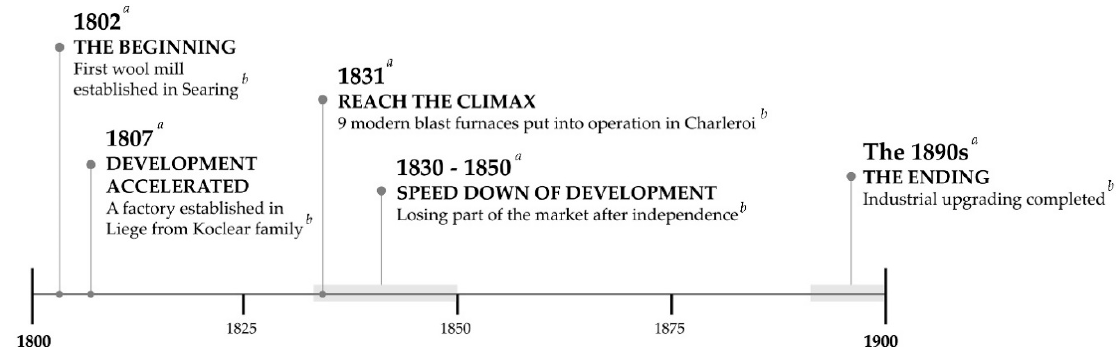
Figure 2. Significant landmarks in the history of industrial development in Belgium (a. Date and event derived from Miklas Tich and Roy Porter (1996). b. Stage was defined by the author and references based on historical events).